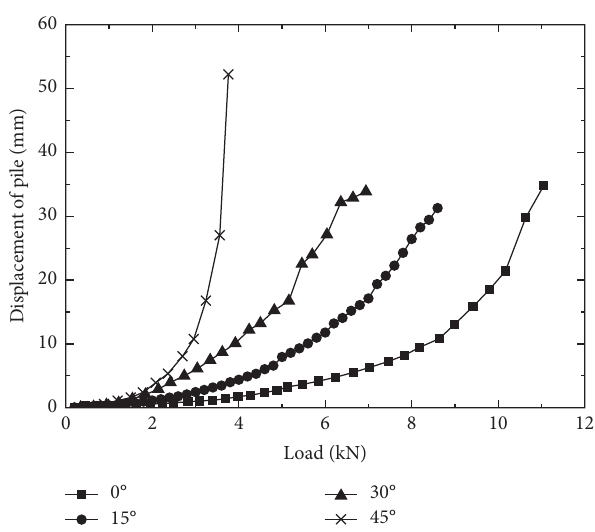
Figure 8: Curves of pile displacement load under 4